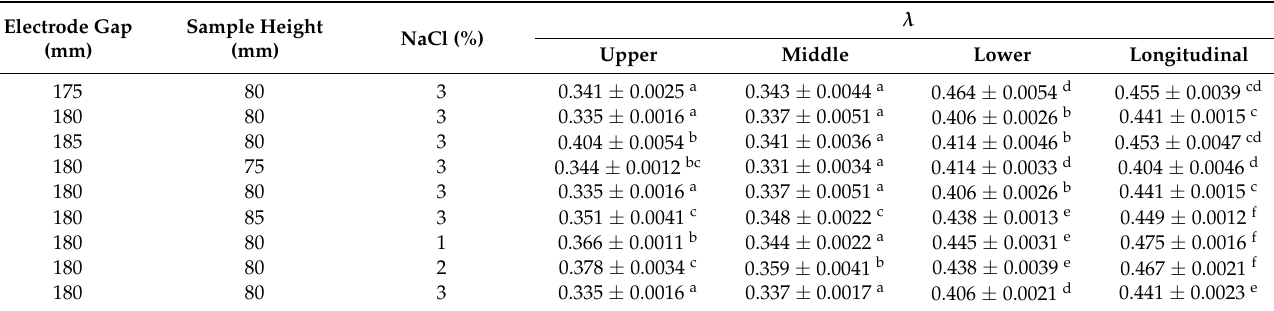
Different lowercase letters indicate a significant difference ( p <